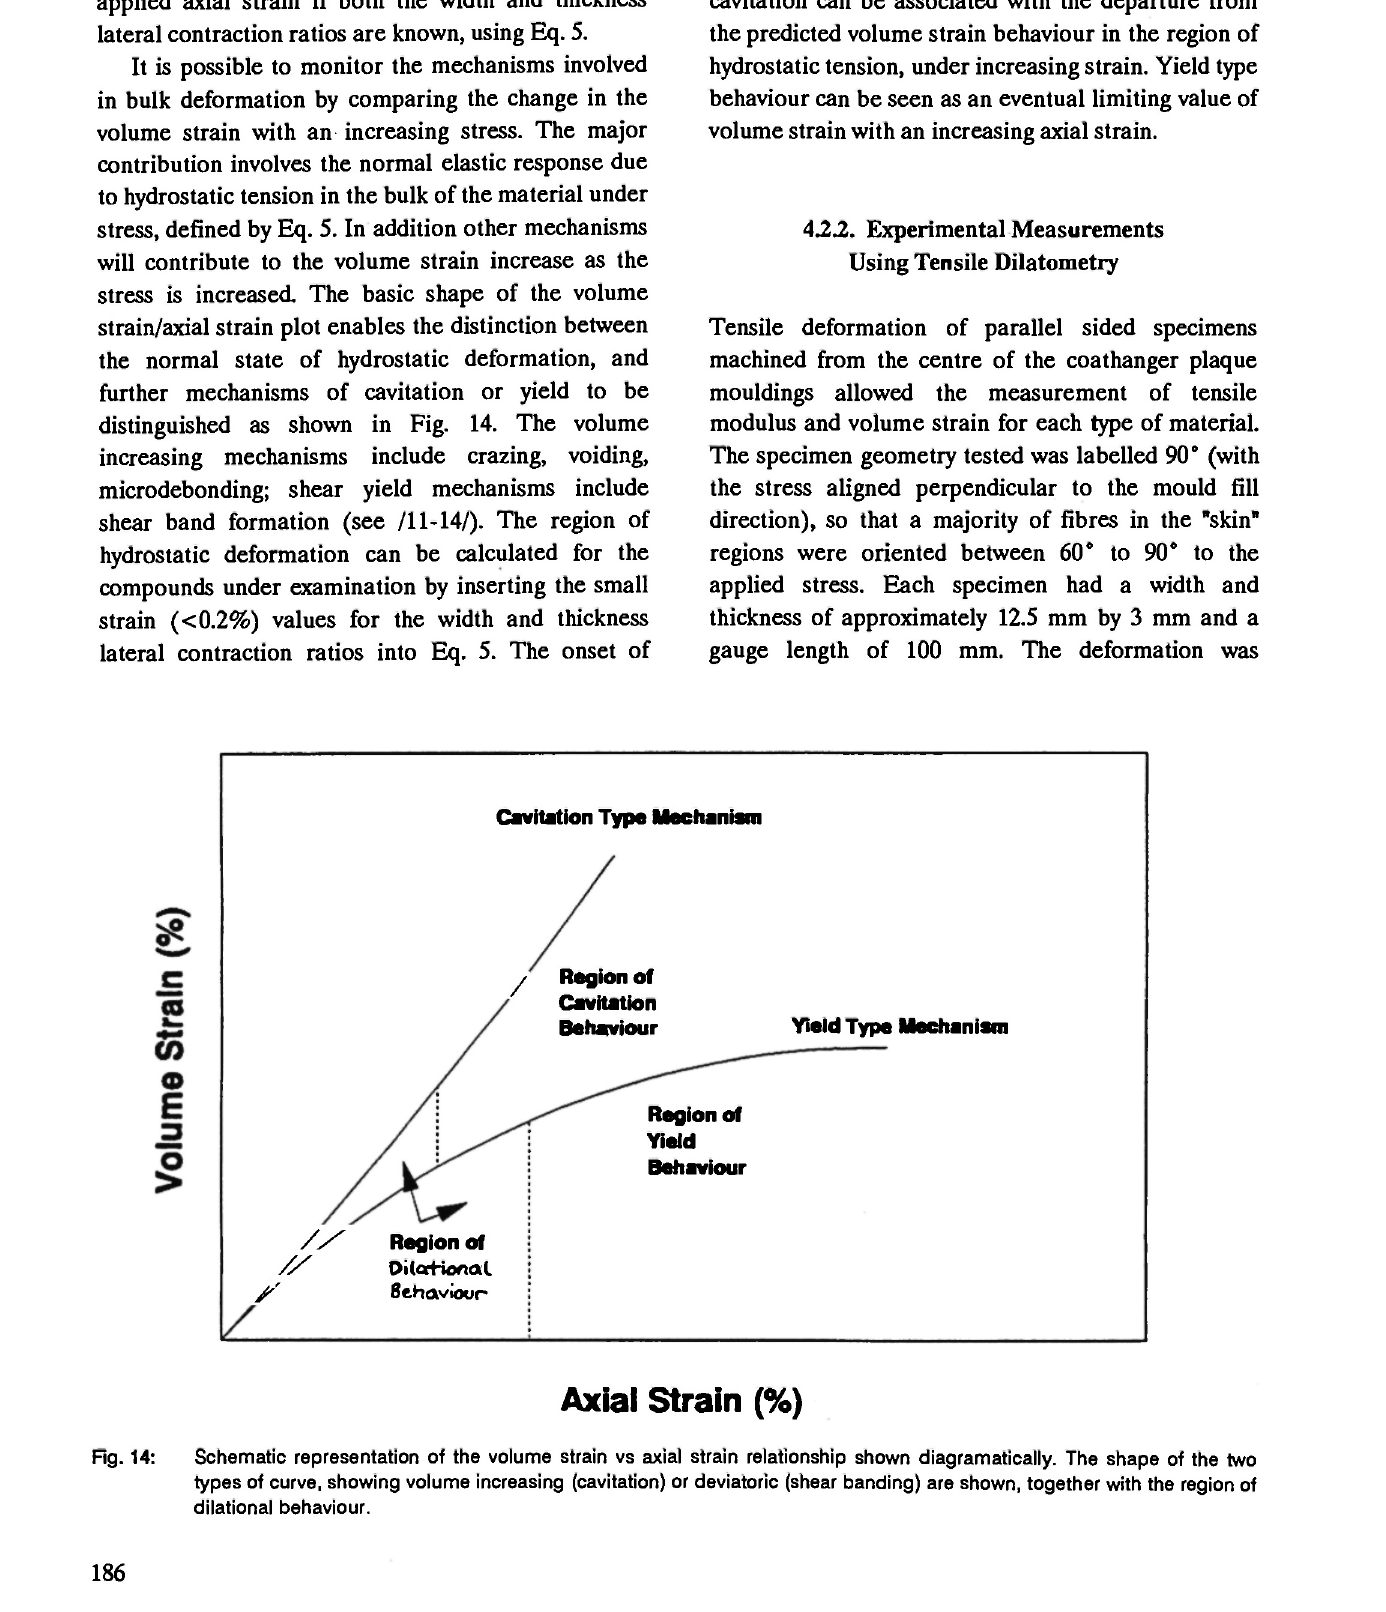
Fig. 14: Schematic representation of the volume strain vs axial strain relationship shown diagramatically. The shape of the two types of curve, showing volume increasing (cavitation) or deviatoric (shear banding) are shown, together with the region of dilational